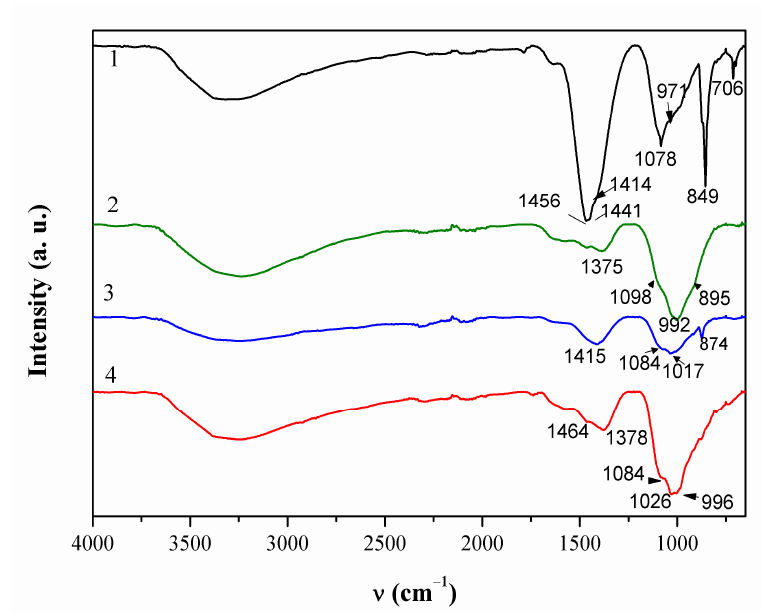
Figure 5. ATR-FTIR spectra collected on patina samples from NI.